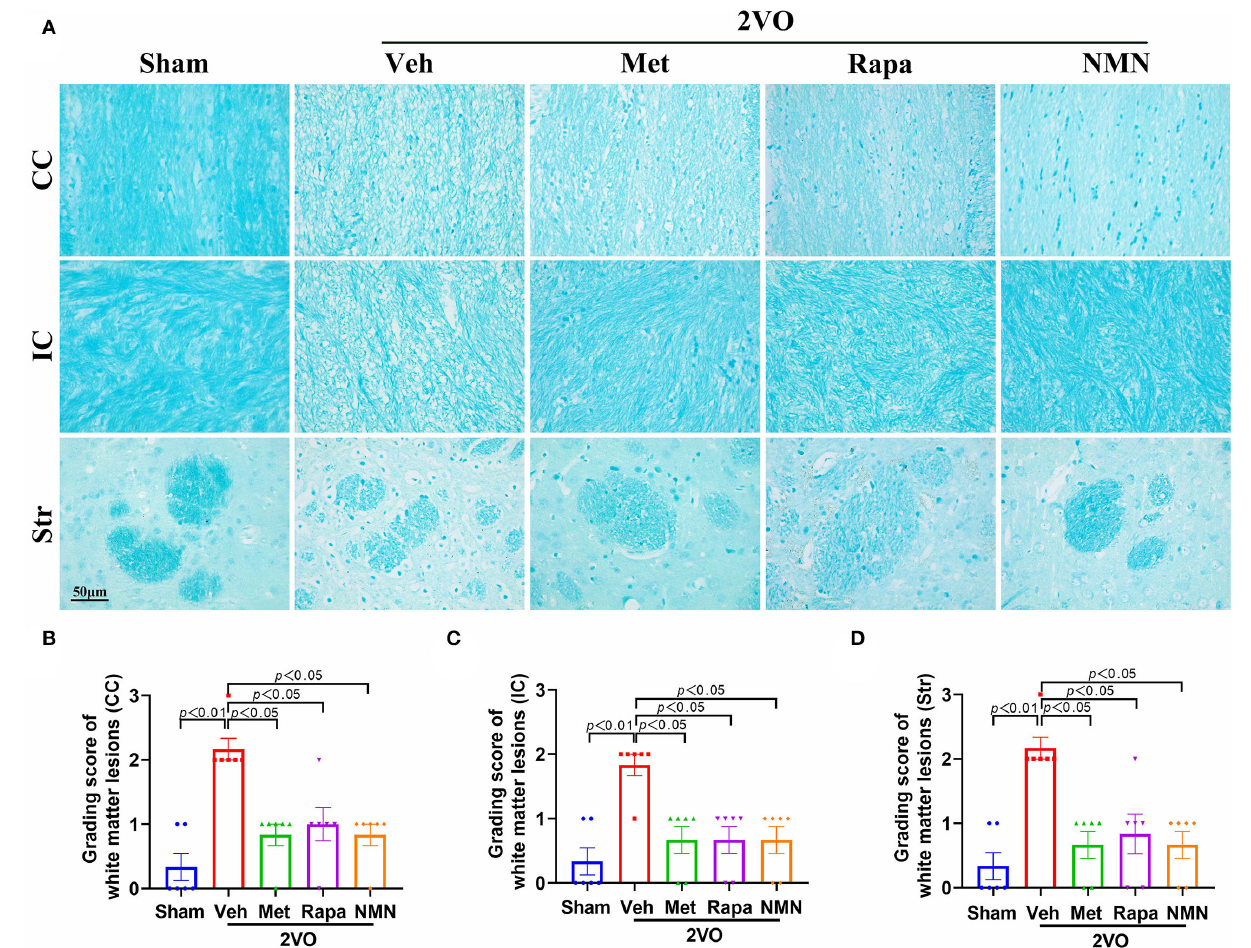
FIGURE 2 | Metformin, rapamycin, or NMN pretreatment ameliorates WMLs in BCCAO rats. (A) Representative images of Luxol fast blue (LFB) staining in the corpus callosum (CC), internal capsule (IC), and striatum (Str) in BCCAO or sham rats pretreated with vehicle (Veh), metformin (Met), rapamycin (Rapa), or NMN (NMN) at 2 weeks before surgery. (B–D) Quantitative analysis of WMLs in BCCAO or sham-operated rats after treatment. The extent of WMLs was graded as normal (Grade 0), disarrangement of nerve fibers (Grade 1), formation of marked vacuoles (Grade 2), and loss of myelinated fibers (Grade 3). All data were shown as mean ± SEM, n = 6 per group. The p -values were assessed by Kruskal–Wallis test with a Dunn post-test. 2VO, two-vessel occlusion.